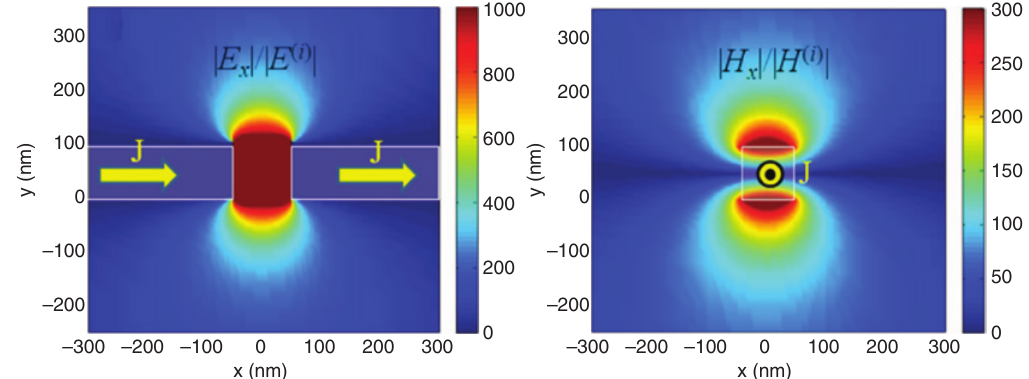
Figure 10: FDTD-calculated electric (left) and magnetic (right) field enhancements with nanogap and nanorod, respectively (gold, h = 100 nm, w = 100 nm). This figure is reproduced from Ref.